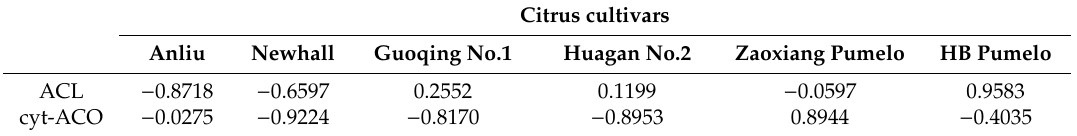
Table 3. Correlation coe ffi cients between citrate concentration and ACL or cyt-ACO in each cultivar. Citrus